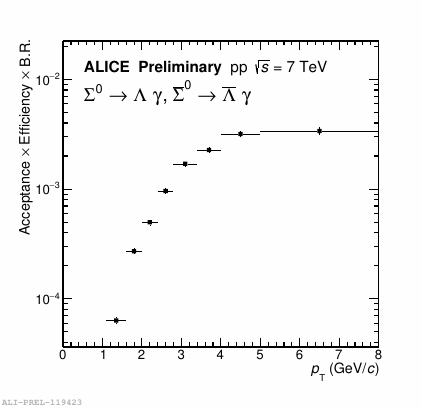
0 y < 0 . 5. Only statistical uncertainties in | |